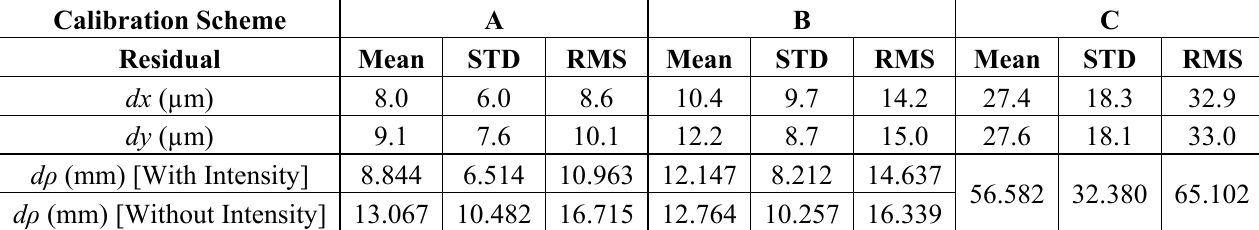
Table 5. Residuals on observations with calibration schemes [A], [B] and